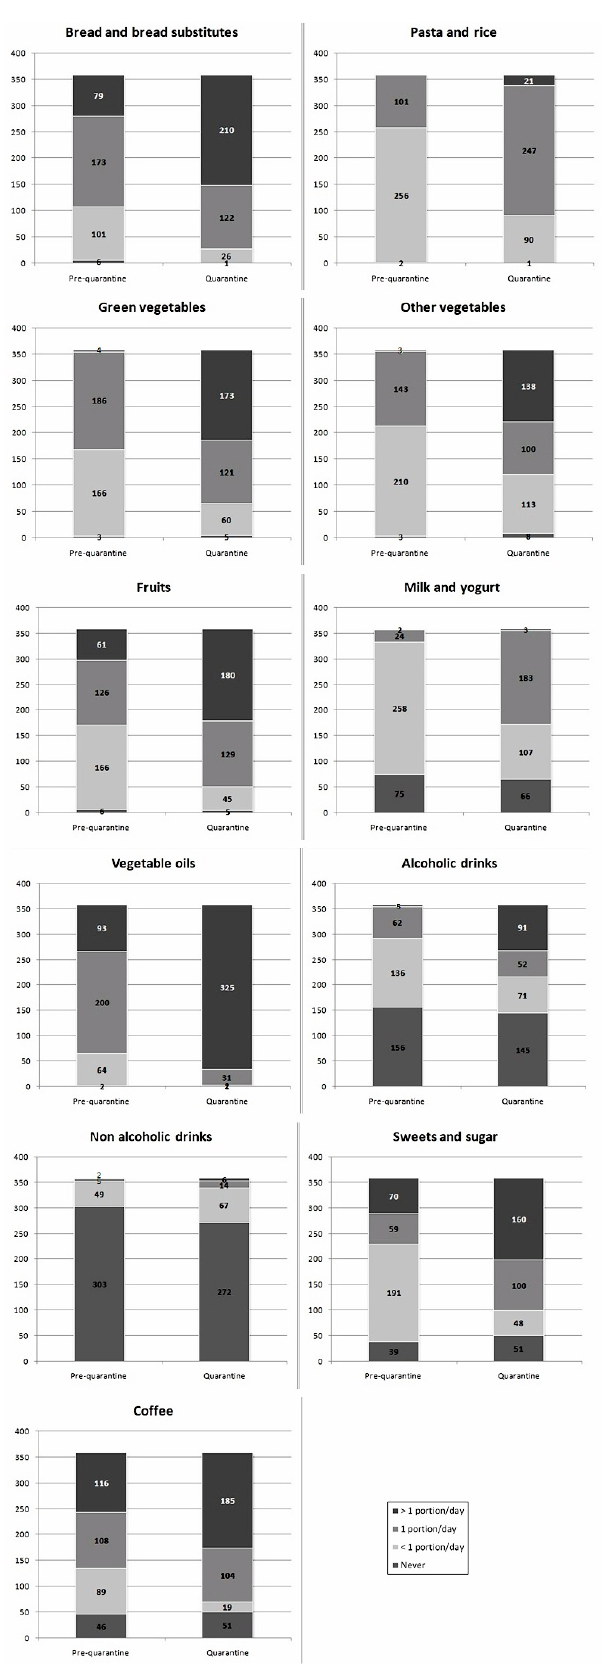
Figure 2. Changes in single food groups intake during quarantine (portions/day).